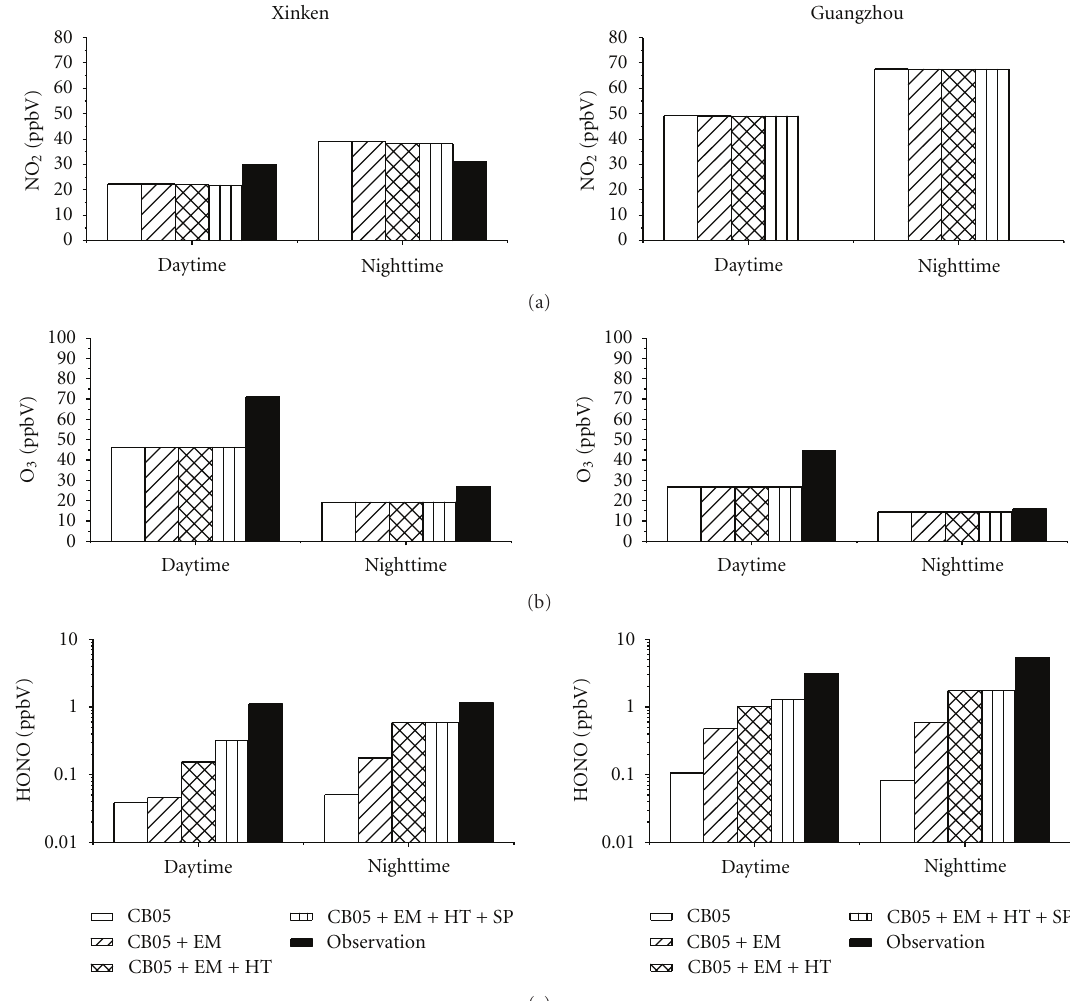
Figure 4: Model validations after incorporation of di ff erent HONO chemistry at Xinken (XK) and Guangzhou (GZ) site for (a) NO 2 , (b) O 3 , and (c) HONO